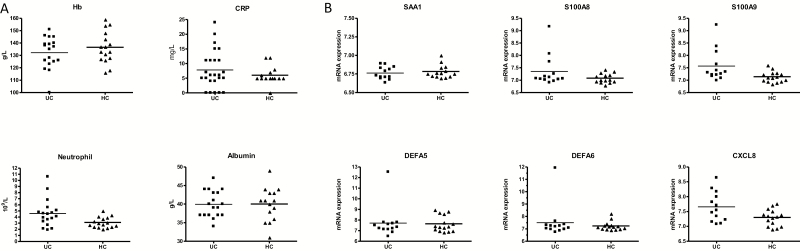
Assessment of inflammatory status of UC patients and controls. A, Systemic inflammatory markers from peripheral blood samples taken from subjects on the day of endoscopy (CRP, Hb). B, Rectal biopsy transcriptomic profiles of known inflammatory genes for all UC and HC subjects (SAA1, serum amyloid 1; S100A8, S100 calcium binding protein A8; S100A9, S100 calcium binding protein A9; DEFA5, defensin A5; DEFA6, defensin A6; CXCL8, interleukin-8). One UC patient was identified to have an elevated inflammatory transcriptomic signature.